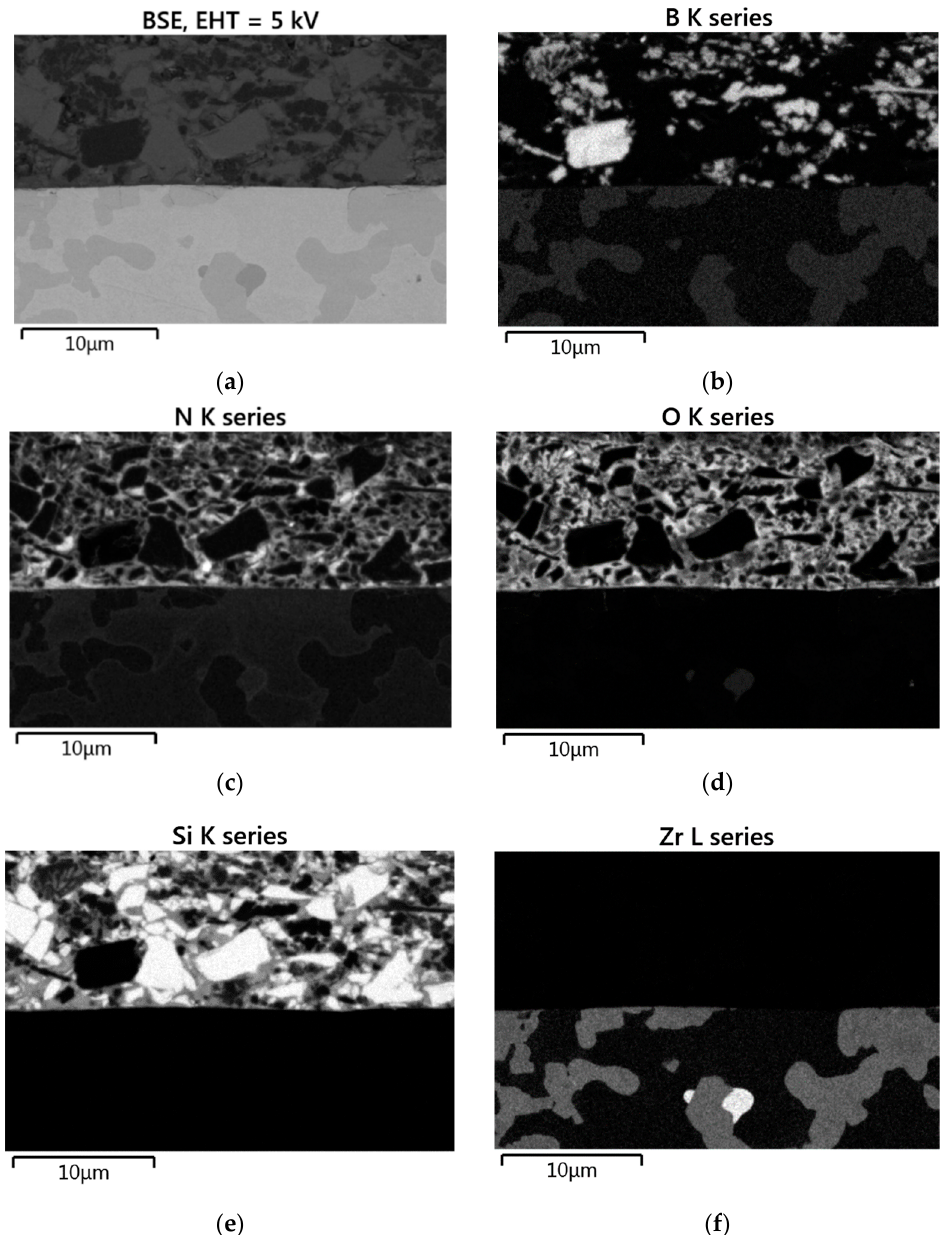
Figure 7. ( a ) SEM micrograph, and ( b – f ) EDS element mapping of a coated Mo-14.8Zr-23B alloy after pyrolysis at 1000 °C in N 2 .